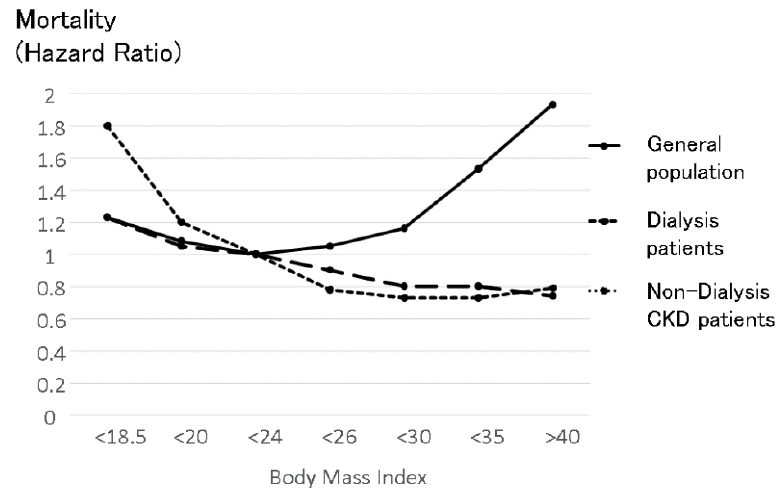
Figure 6. The relationship between body mass index and mortality in the general population, non- dialysis CKD patients and dialysis patients. The upper U-shaped line shows the relationship between body mass index (BMI) and mortality in the general population, which was made from data reported based on 900,000 subjects [33]. The line indicates the average mortality in men and in women. The effect of BMI on mortality in women was smaller than in men in all BMI categories. High BMI was associated with high mortality in the general population, while low BMI was also associated with high mortality. The middle line shows the relationship between BMI and mortality in dialysis patients reported by Kalantar-Zadeh et al. [31]. Higher BMI in dialysis patients consistently improves prognosis in dialysis patients. This divergence from the relationship in the general population was named the “obesity paradox”. The bottom line shows the relationship between BMI and mortality in non-dialysis CKD patients reported by Navaneethan-SD et al. [34]. The obesity paradox was observed in non-dialysis patients. Simple comparisons should be considered because these three lines refer to different cohorts that have different countries of origin, observation periods, and numbers.